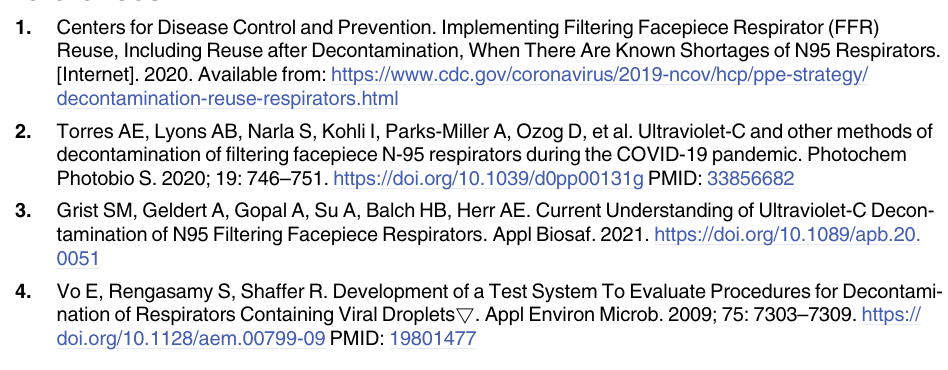
S2 Table. Maximum log reduction achievable for each mask